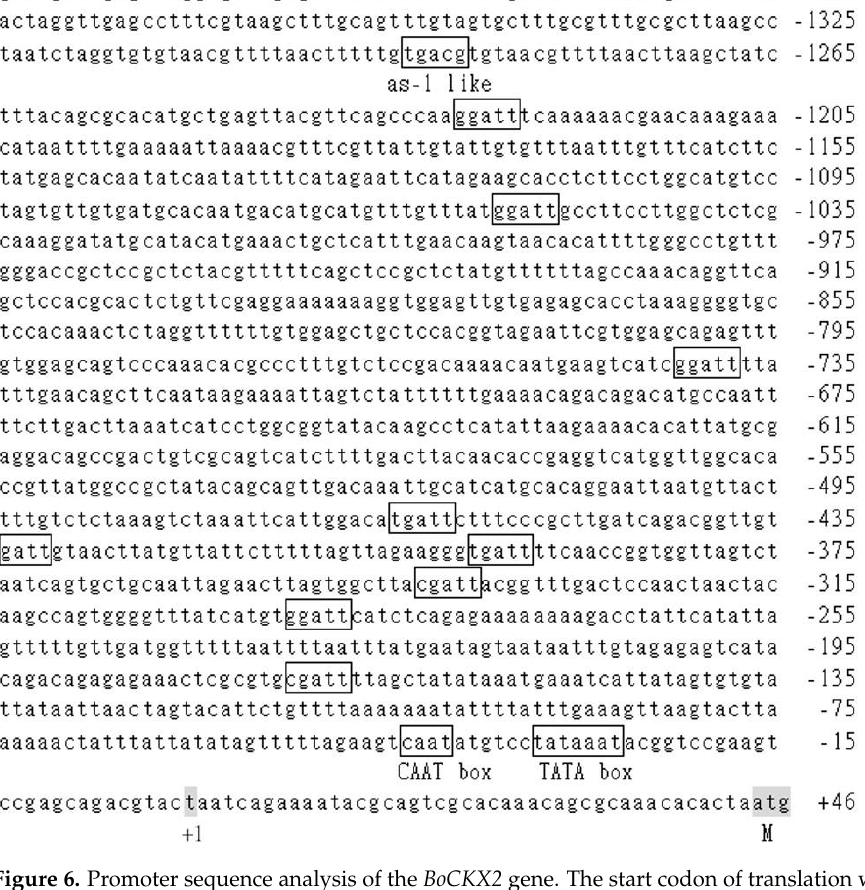
Figure 6. Promoter sequence analysis of the BoCKX2 gene. The start codon of translation was shaded. The predicted transcriptional start site was indicated as “+1”. The putative functional TATA box, CAAT box, as-1 like motif and ten NGATT elements were designated.